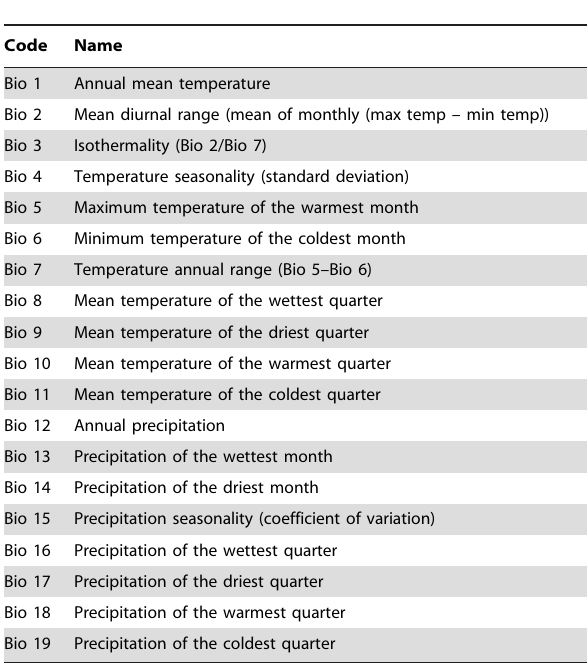
Table 1. Bioclimatic variables considered in the distribution models of limber